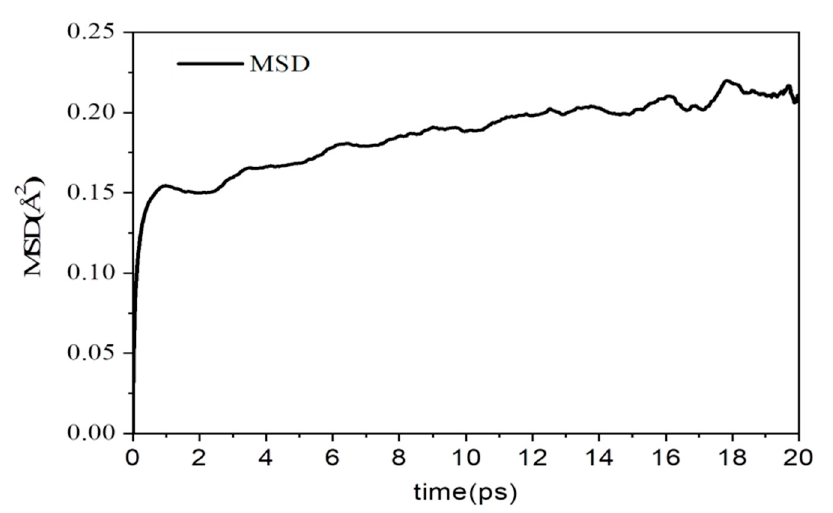
Figure 3. The mean square displacement (MSD) of protons in our simulation system at 423 K over a period of 20 ps.